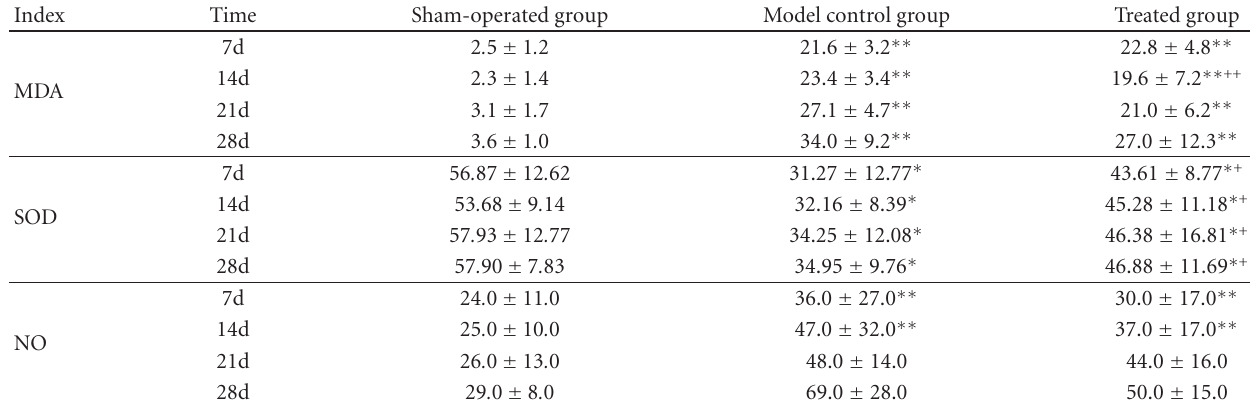
Table 2: Comparison of di ff erent indexes in blood ( X ± S ).